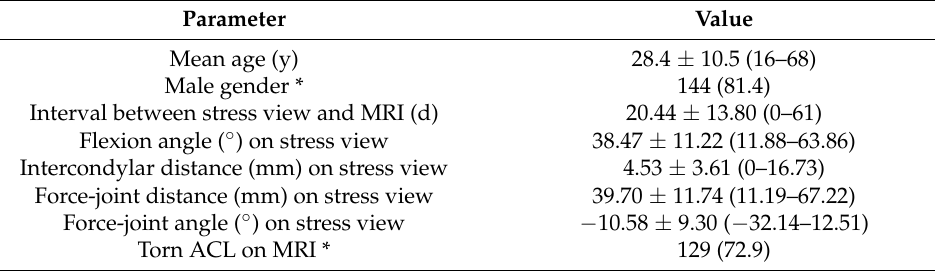
Table 1. Clinical data in 177 patients with knee stress radiographies.